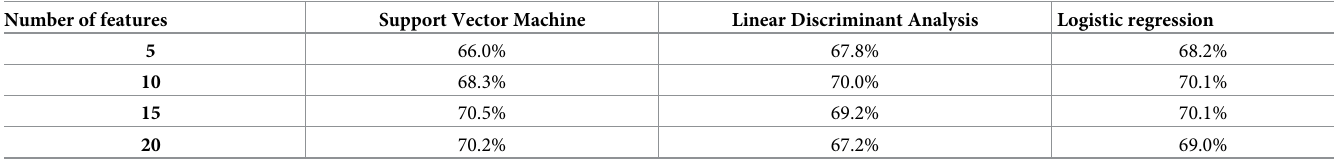
Table 2. Detailed classification results (accuracy) obtained with Support Vector Machine, logistic regression, and linear discriminant analysis for minimum Redun- dancy Maximum Relevance sets between 5–20 features. Number of features